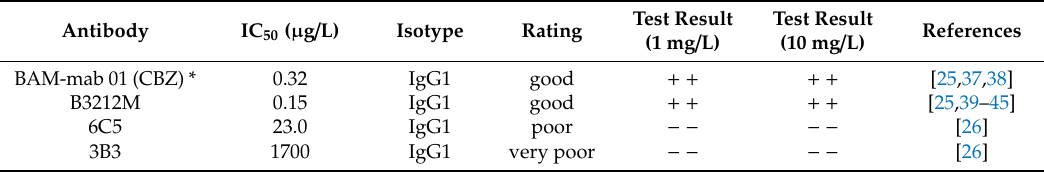
Table 1. Monoclonal antibodies used for the simulated screening.